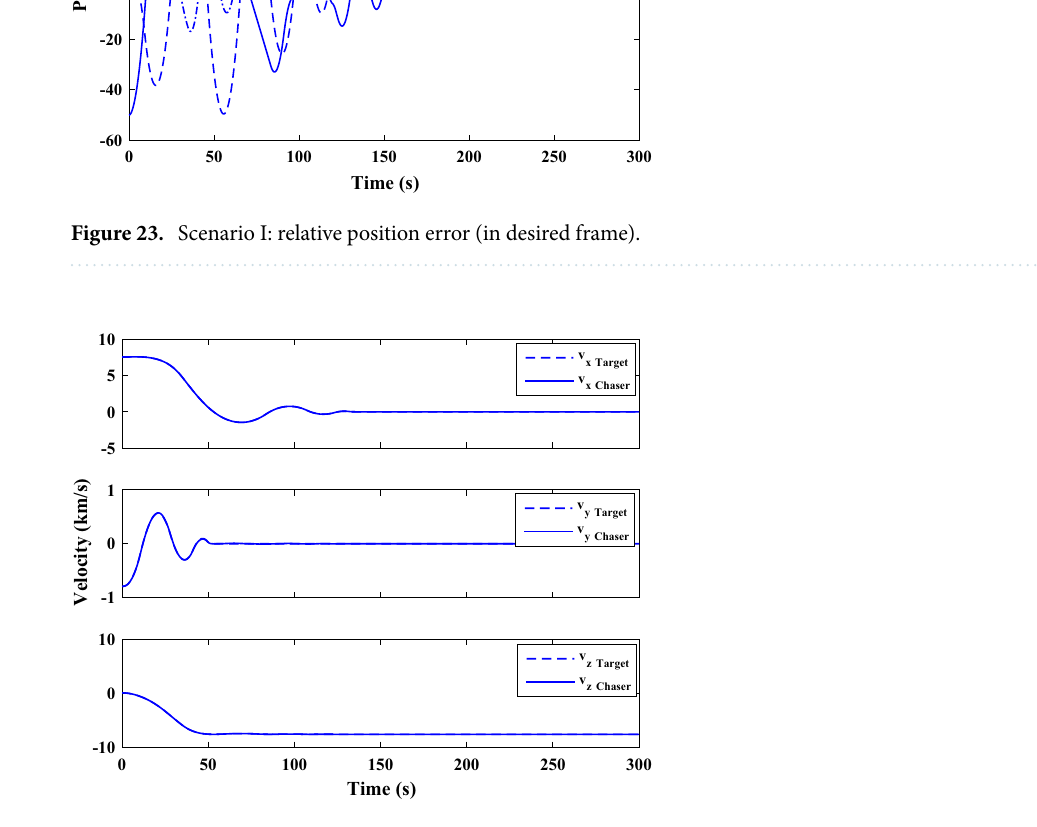
Figure 24. Scenario I: linear velocity tracking (in chaser body